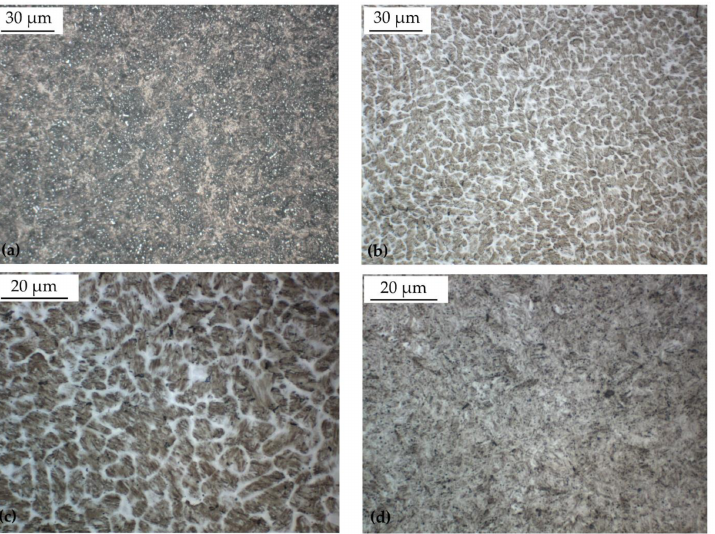
Figure 8. Optical micrographs of the microstructure of samples on the YZ plane. ( a ) 100Cr6 steel quenched and tempered (Q + T), ( b , c ) sample C as-ESFed, and ( d ) sample D in the Q + T condition.